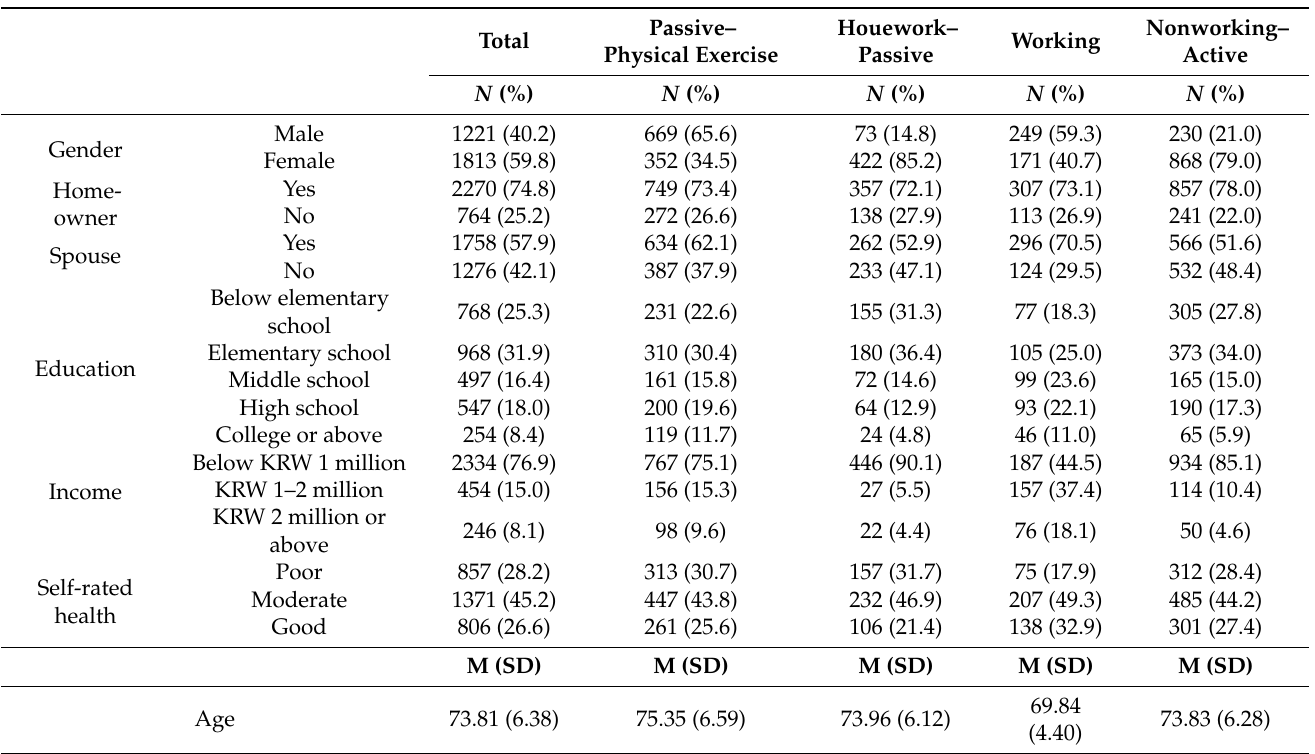
Table 5. Characteristics of Korean older adults by classes (KTUS 2014).